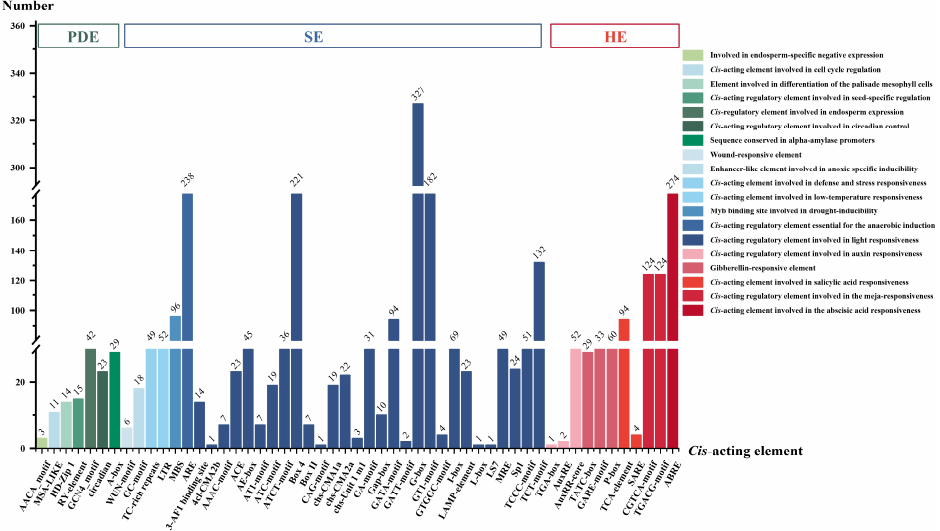
Figure 4. The number of various cis -acting elements. Different colors represent different functions. Each color group represents a different kind. The abbreviations in the above color group block, PDE: plant development-related elements; SE: stress-related elements; HE: hormone-related elements. The figure above each column represents the number of cis -acting